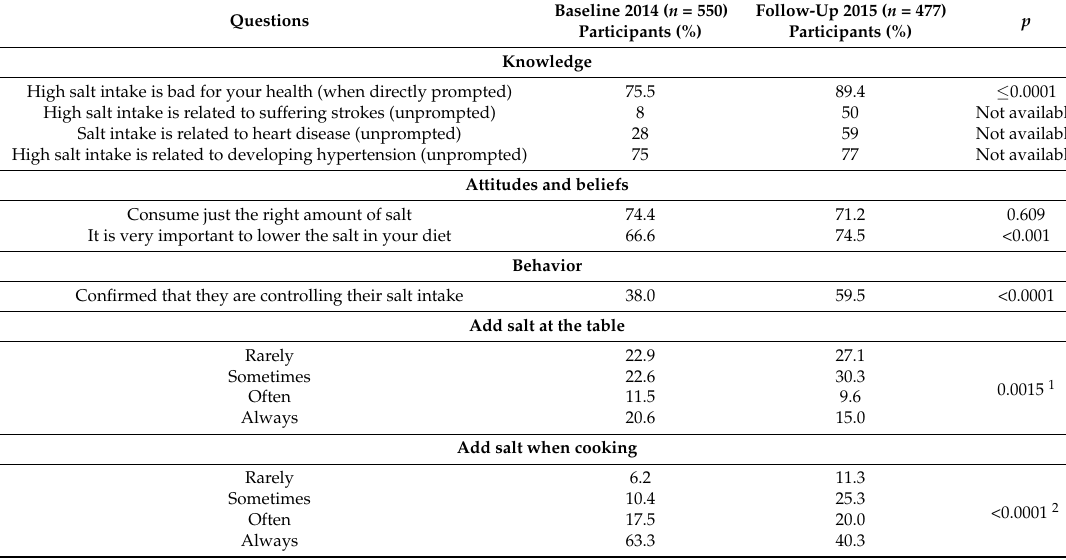
Table 4. Knowledge, attitude, beliefs and self-reported behavior of participants regarding salt use before and after the campaign.